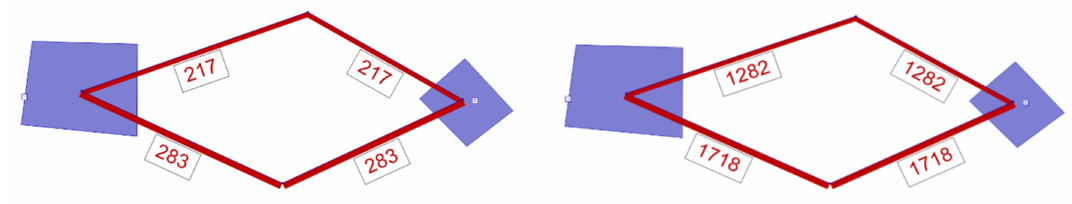
Figure 15. Example results of the traffic assignment, source: own.